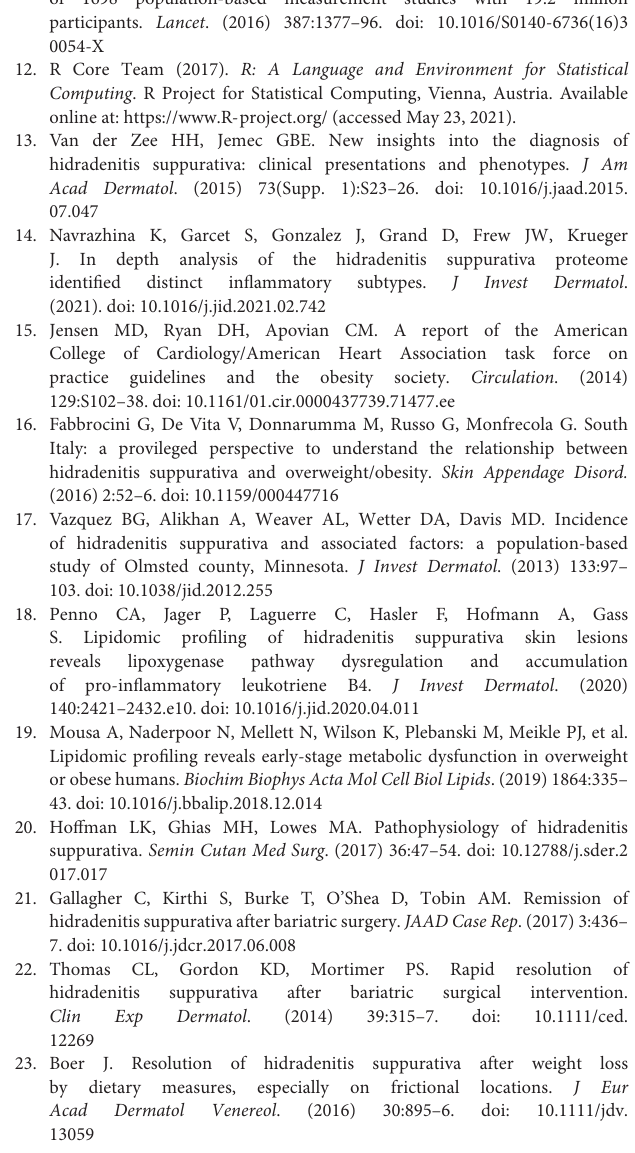
Supplementary Table 1 | Table comparing the demographic and disease specific characteristics of participants in PIONEER 1 and PIONEER 2. Supplementary Table 2 | Regression Models with Baseline AN Count as a significant covariate in achieving IHS4 category change (Model 3) and change in AN count (Model 4) in PIONEER